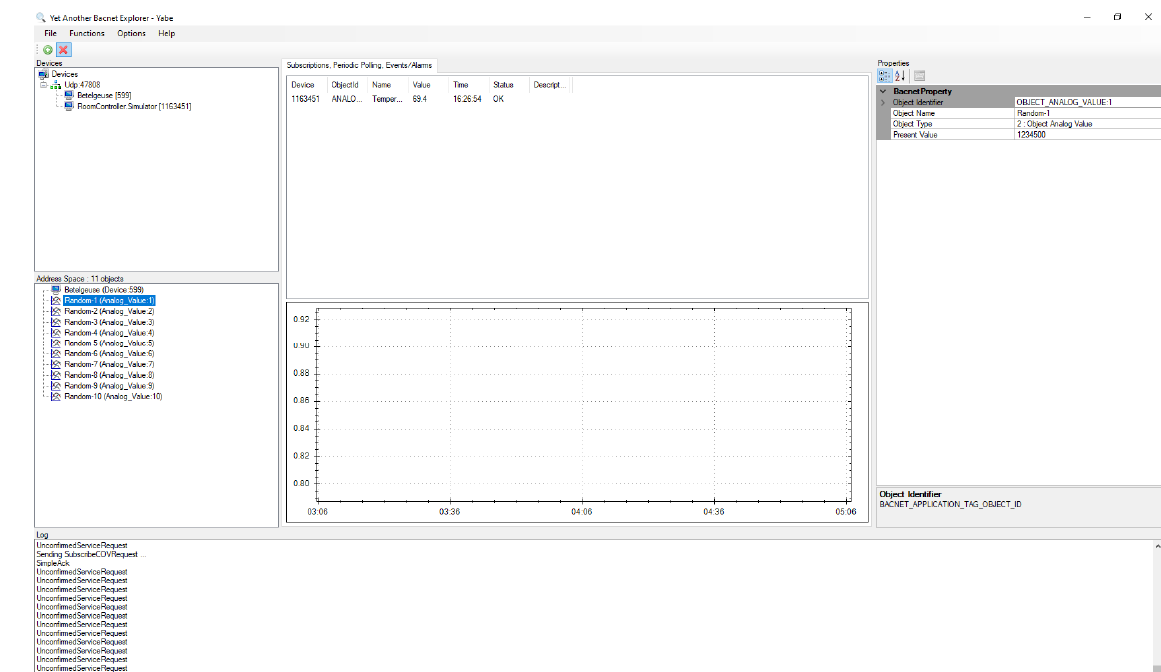
Figure 8. YABE platform with virtual BACnet device and properties value.